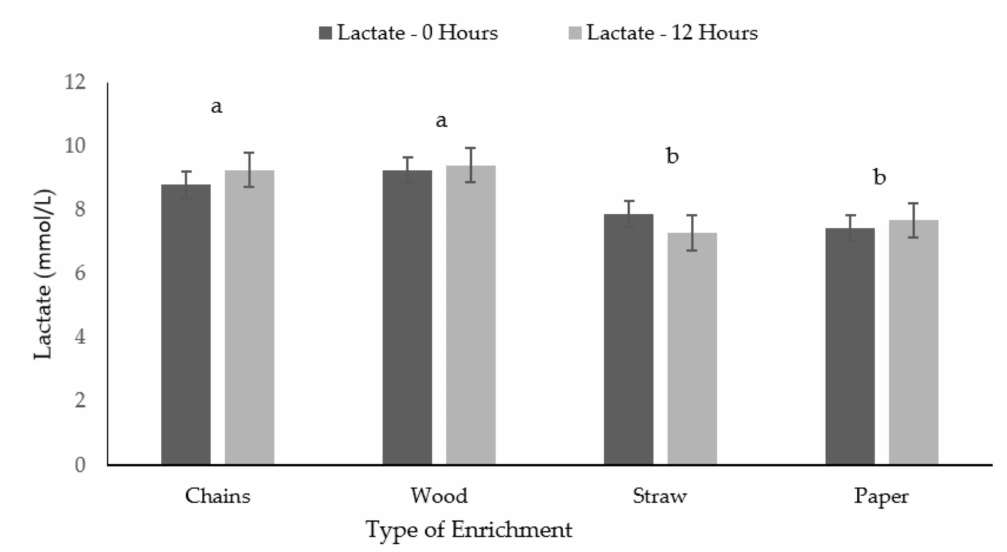
Figure 4. Means (and standard errors) of Lactate for the four types of enrichment materials after the two di ff erent fasting times (0 and 12 h). Di ff erent superscripts indicate significant di ff erences due to treatment ( P <